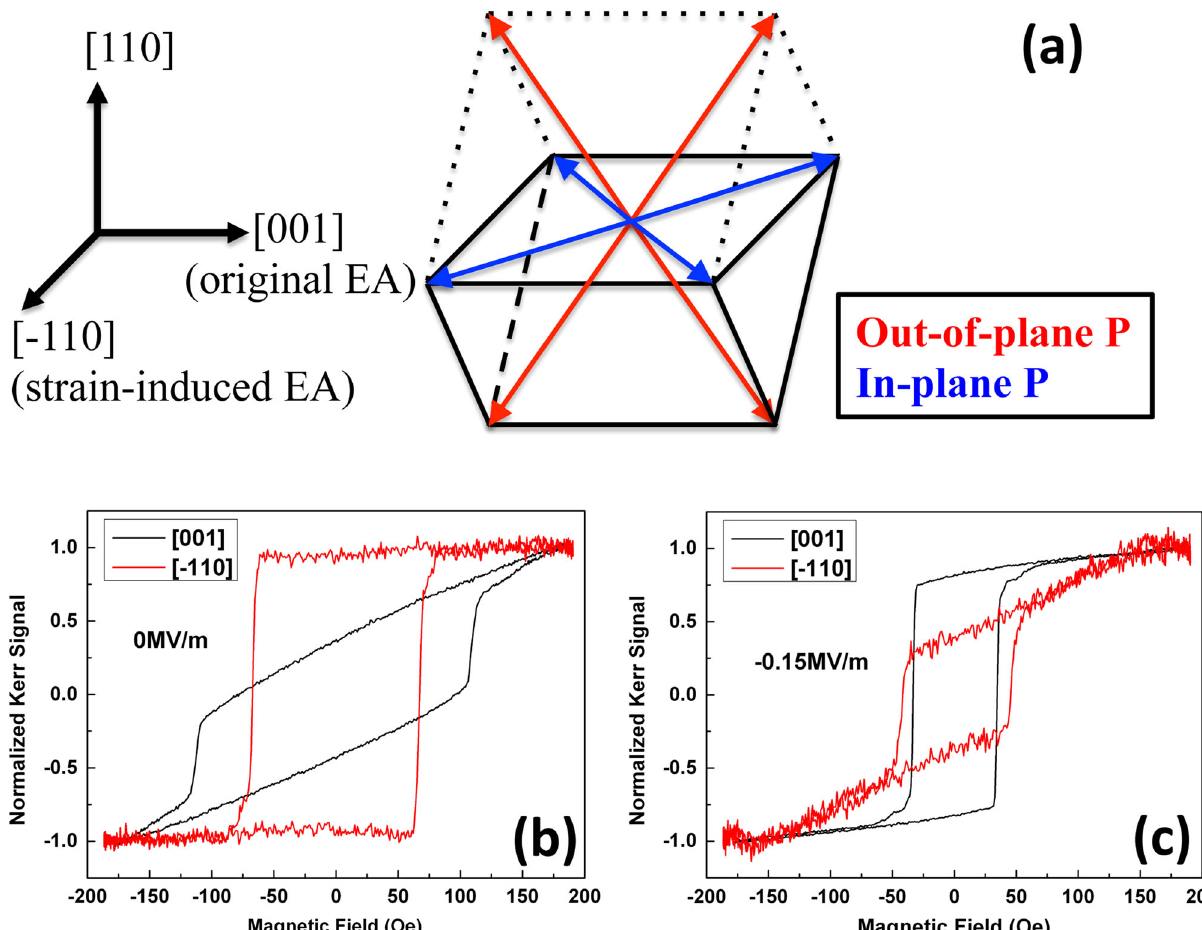
Fig. 6 Electric fi eld manipulation of uniaxial anisotropy. a Schematic of the polarization directions of PMN-PT(110) ferroelectric single crystal substrates. Switching the polarization from in-plane to out-of-plane could induce an anisotropic compressive strain in [ − 110], which will generate an easy axis of Ni layer in the same direction. b , c MOKE measured M-H loops of the Ni(10 nm)/NiO(1.6 nm)/PMN-PT(110) heterostructure with different out-of-plane electric fi elds. A +0.8 MV/m electric fi eld is applied to pre-polarize the PMN-PT(110) substrate. To re fl ect the magnetic properties of the same area on the sample, M-H loops of [001] and [ − 110] directions are measured by longitudinal and transverse Kerr effect, respectively, which could be carried out